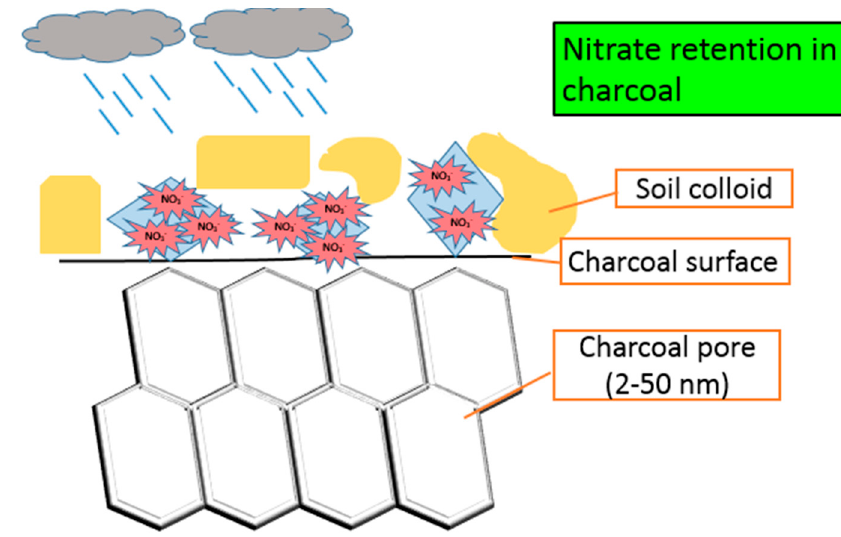
Figure 2. Schematic illustration of the process of leaching with charcoal.